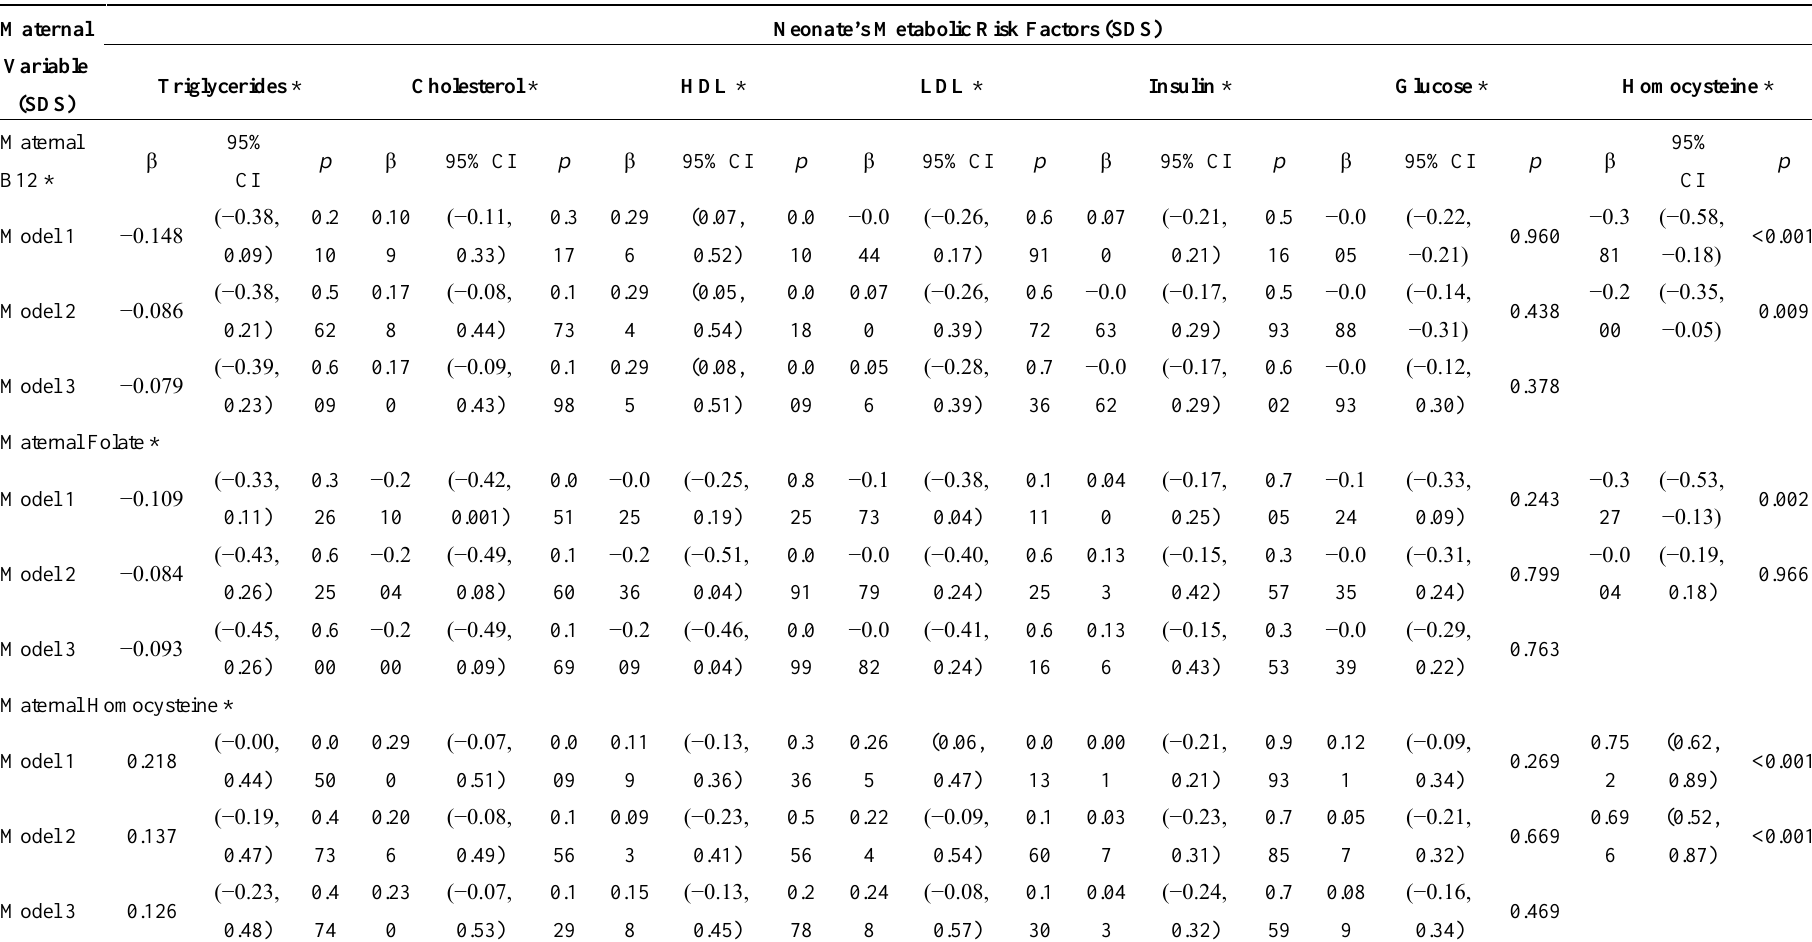
Table 4. Association of maternal B12, folate and homocysteine with neonate metabolic risk